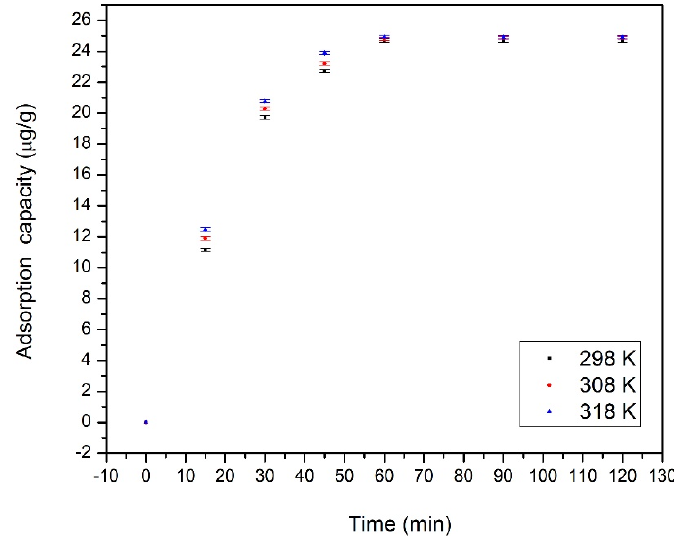
Figure 5. Effect of contact time and temperature on Cd adsorption on functionalized chitosan.